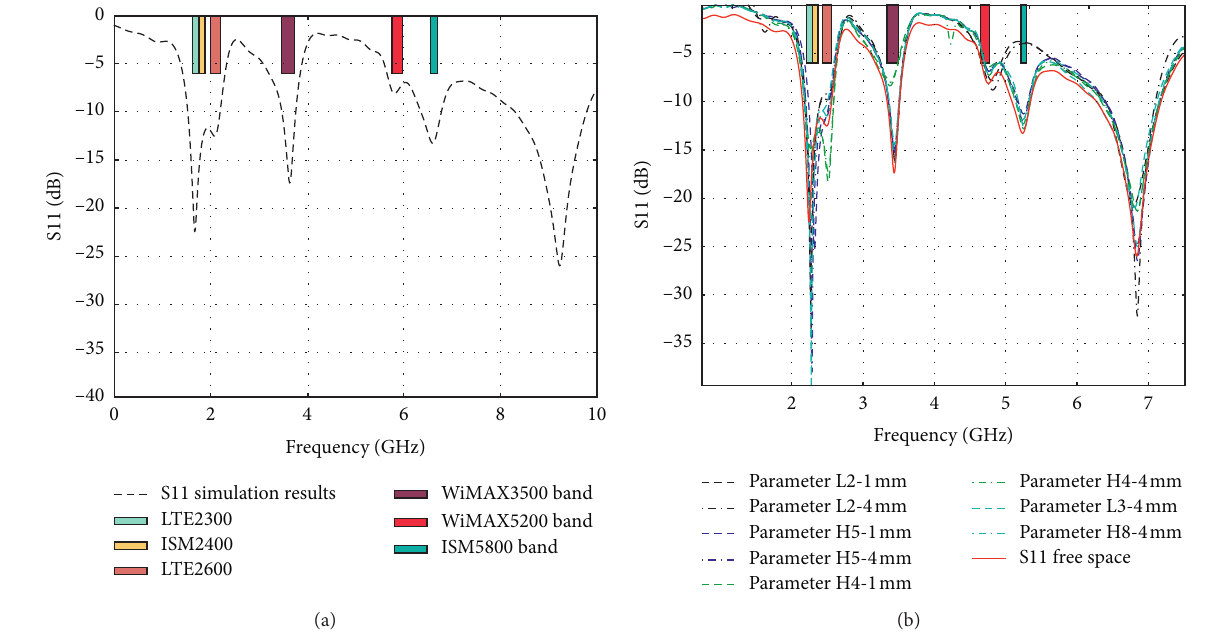
Figure 3: (a) S11 simulation results of each configuration. (b) Influence of antenna parameters on S11 simulation